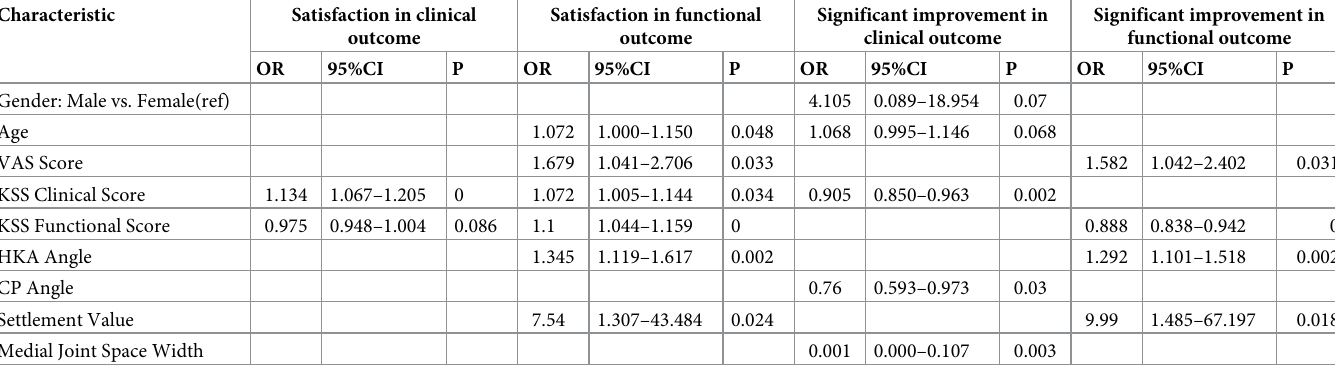
Table 2. Odds ratios of Multivariate logistic regression analyses for outcome of interest versus patient clinical and radiological characteristic (only variables in equation are shown in the table).